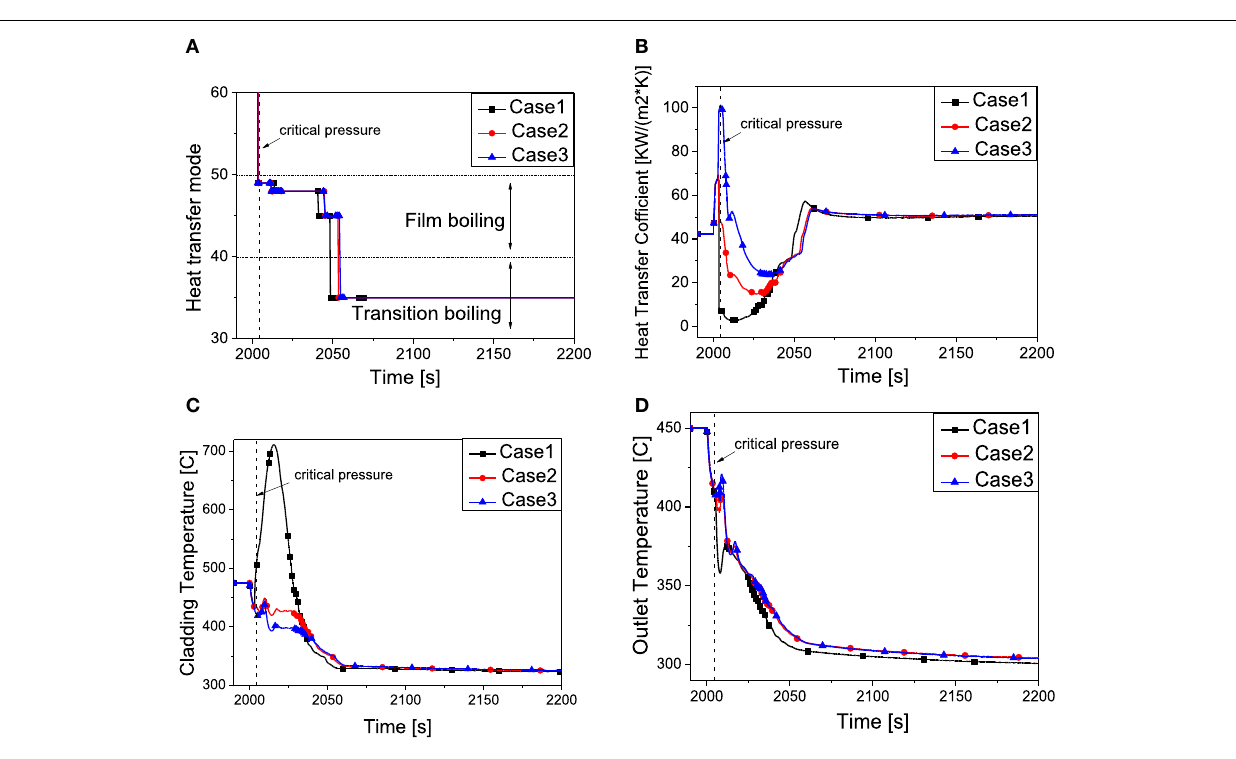
Frontiers in Energy Research | Nuclear